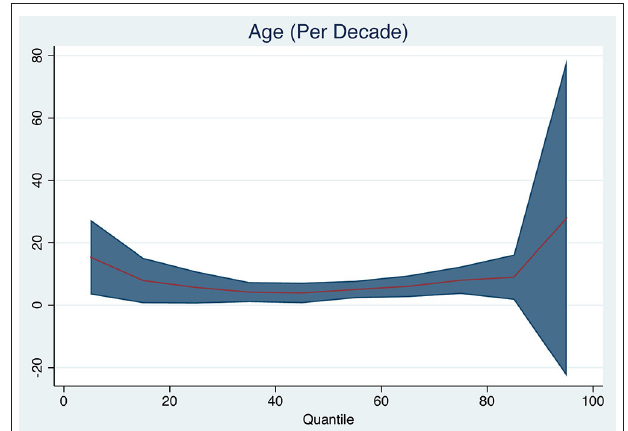
FIGURE 1 | Quantile plot showing estimated brain volume change in milliliter and 95% confidence limits ( y -axis) according to age (decades). An x -axis shows the quantile levels. Positive numbers in the y -axis reflect decrease in brain volume.